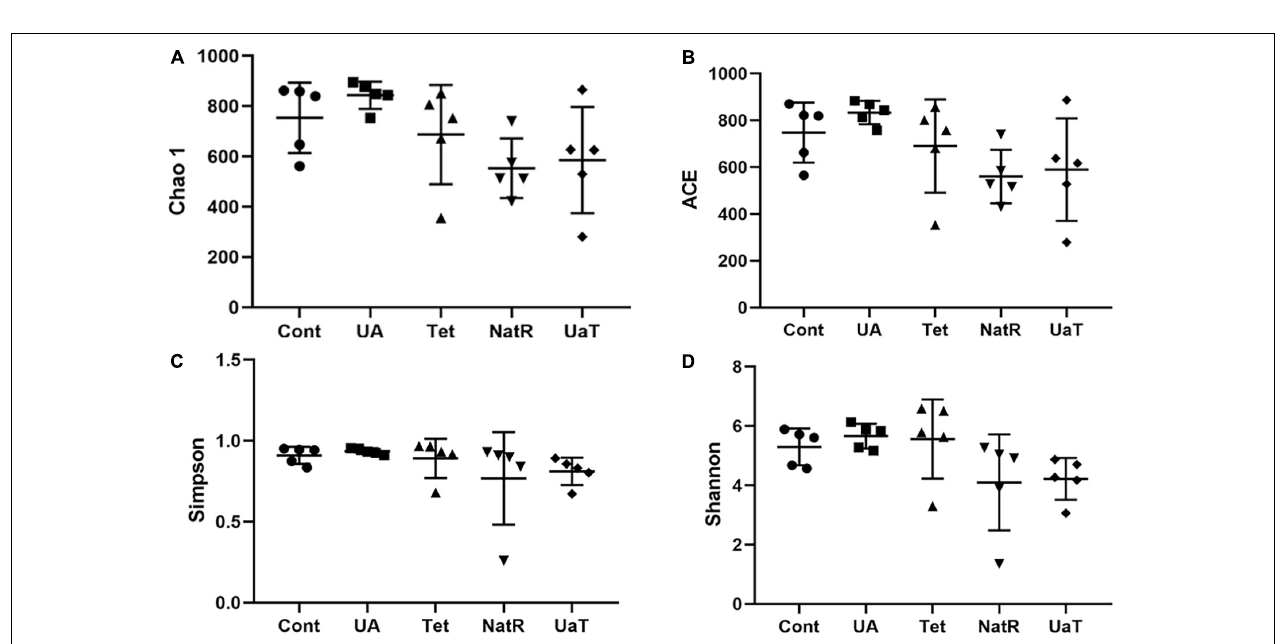
FIGURE 6 | Analysis of alpha-diversity in the five experimental groups on day 28. Chao1 (A) and ACE (B) were used as richness estimators. Simpson (C) and Shannon (D) were used as diversities estimators. All group names correspond to those described in the legend of Figure 2 .